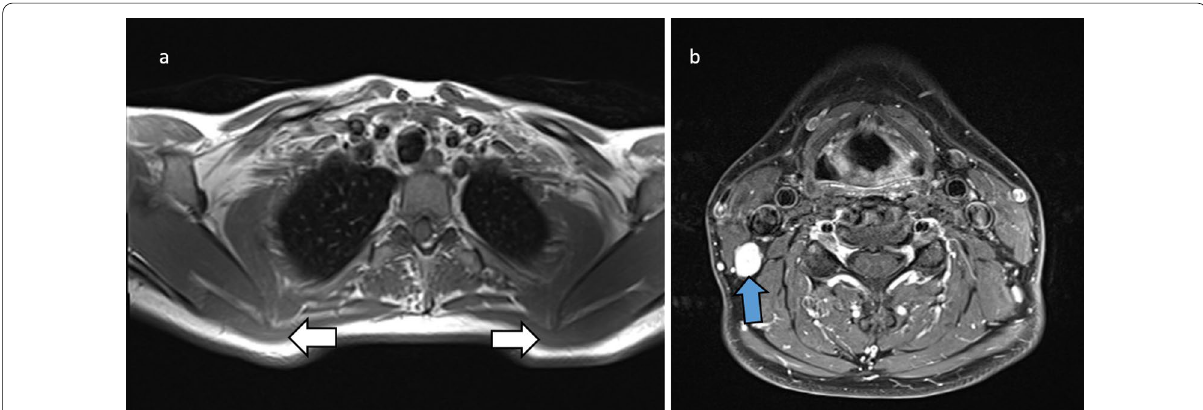
Fig. 2 37-year-old female with lateral scapular winging after schwannoma excision. Axial T1 at the level of the thoracic inlet ( a ) demonstrates asymmetry of the trapezius muscles (white arrows) with right-sided volume loss. Axial T1 fat-saturated post-contrast study ( b ) shows the avidly-enhancing schwannoma, which was located at level 2B in the upper posterior neck, deep to the upper sternocleidomastoid muscle and immediately posterior to the right internal jugular vein (blue arrow). This is along the expected path of the accessory nerve. While the nerve lesion in this case was caused by surgery, the illustrated muscle changes are also seen in entrapment